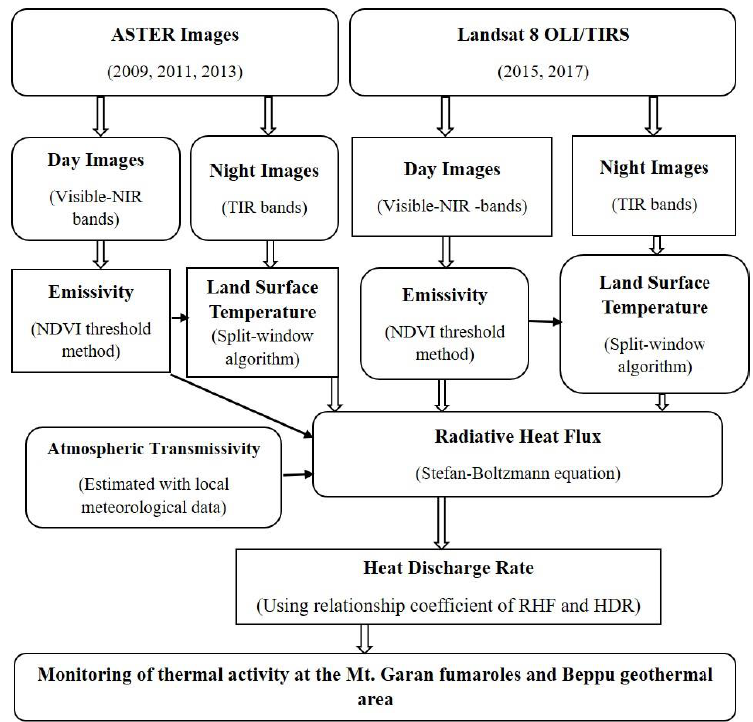
Figure 3. Satellite image processing flowchart of the study. Both day- and nighttime images from ASTER and Landsat 8 sensors were used to estimate spectral emissivity and land surface temperature using the various methods listed above. NIR, near-infrared; TIR, thermal infrared; NDVI, normalized differential vegetation index; RHF, radiative heat flux; HDR, heat discharge rate.